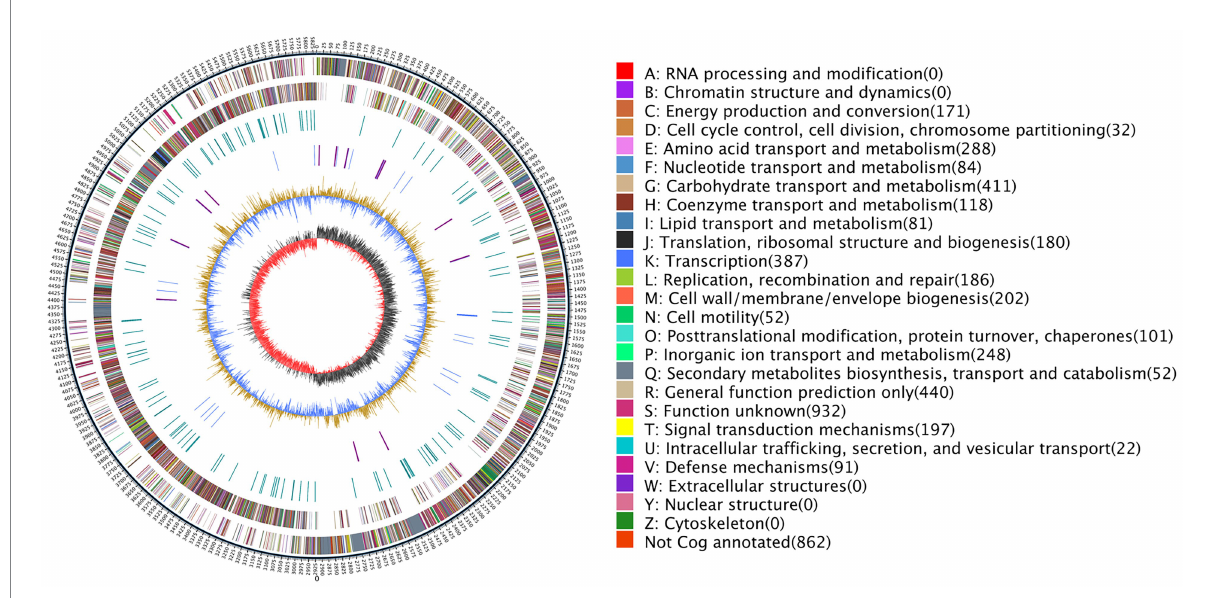
FIGURE 3 Genome map of Paenibacillus peoriae ZBSF16. The distribution of the circle from the outside indicates the genome size, forward CDS, reverse CDS, repeat sequence, tRNA (blue), rRNA (purple), GC ratio (yellow and blue indicate regions where the GC ratio is higher than average and lower than average, respectively), and CG skew positive (dark) and negative